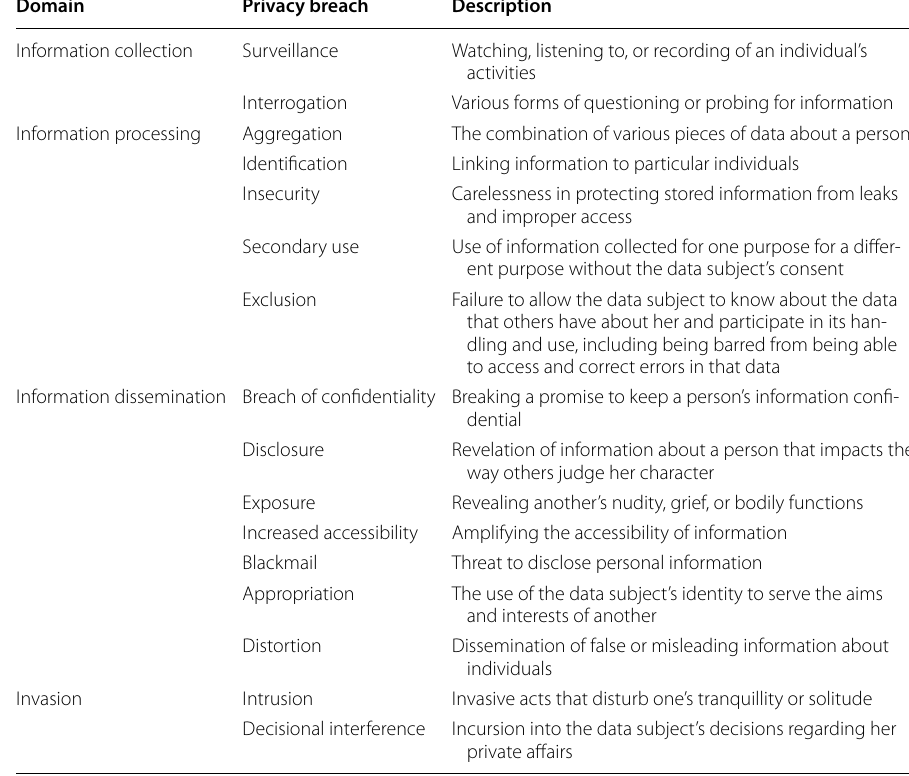
Table 3 A taxonomy of privacy breaches and harms. Source: compiled by Kitchin [81] from Solove